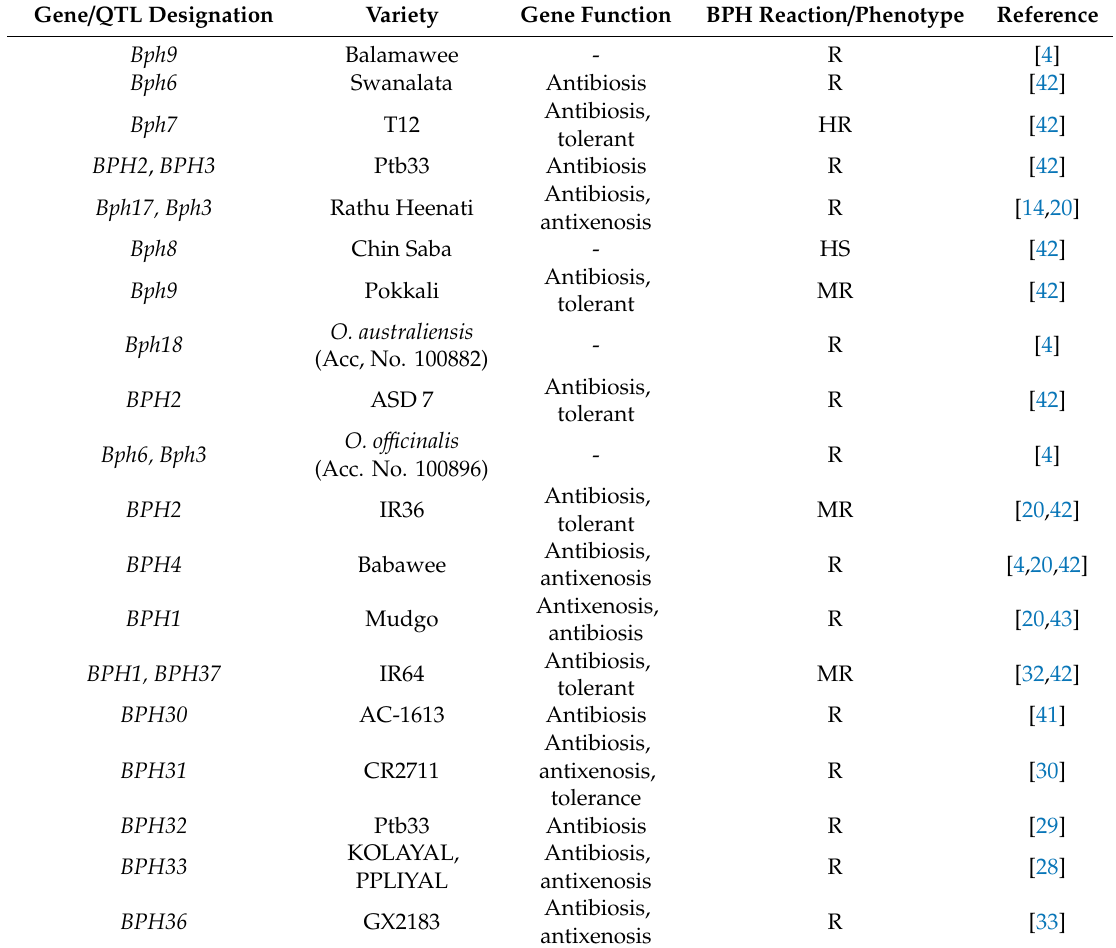
Table 1. Some brown planthopper (BPH)-resistant donor varieties used in many rice breeding programme and their mechanisms of